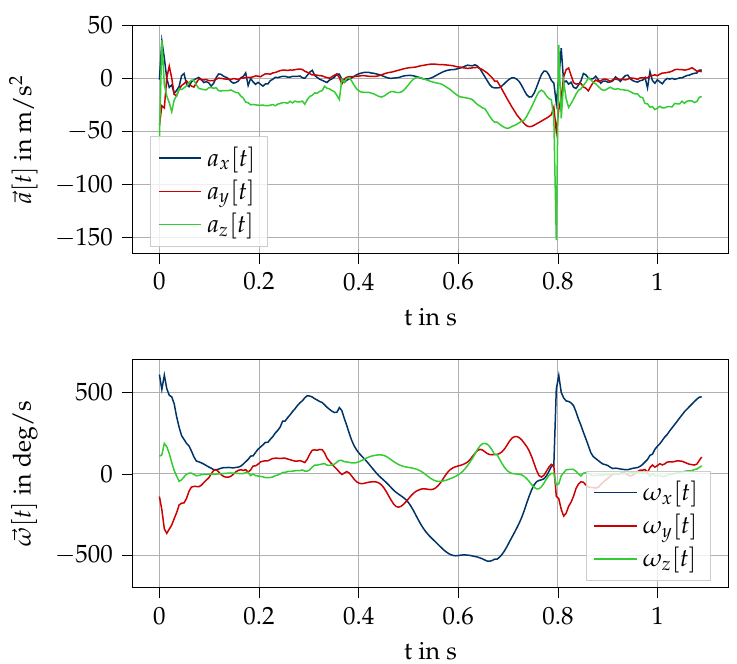
Figure A1. Acceleration (cid:126) a [ t ] and annular rate (cid:126) ω [ t ] raw data of heel sensor.